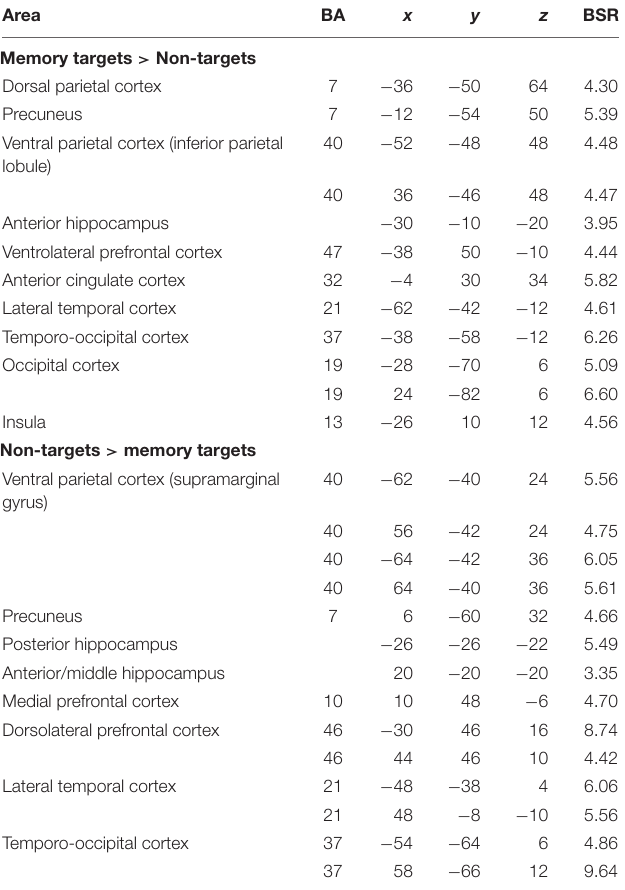
A common finding of these studies is that DPC regions respond more to recognition hits when studied items are infrequent